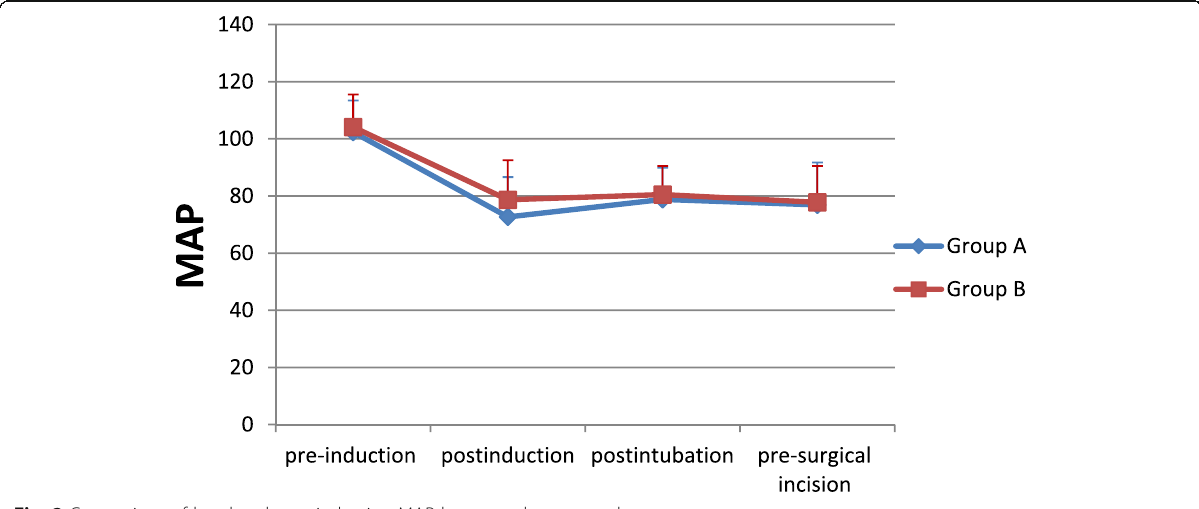
Fig. 2 Comparison of basal and post-induction MAP between the two study groups